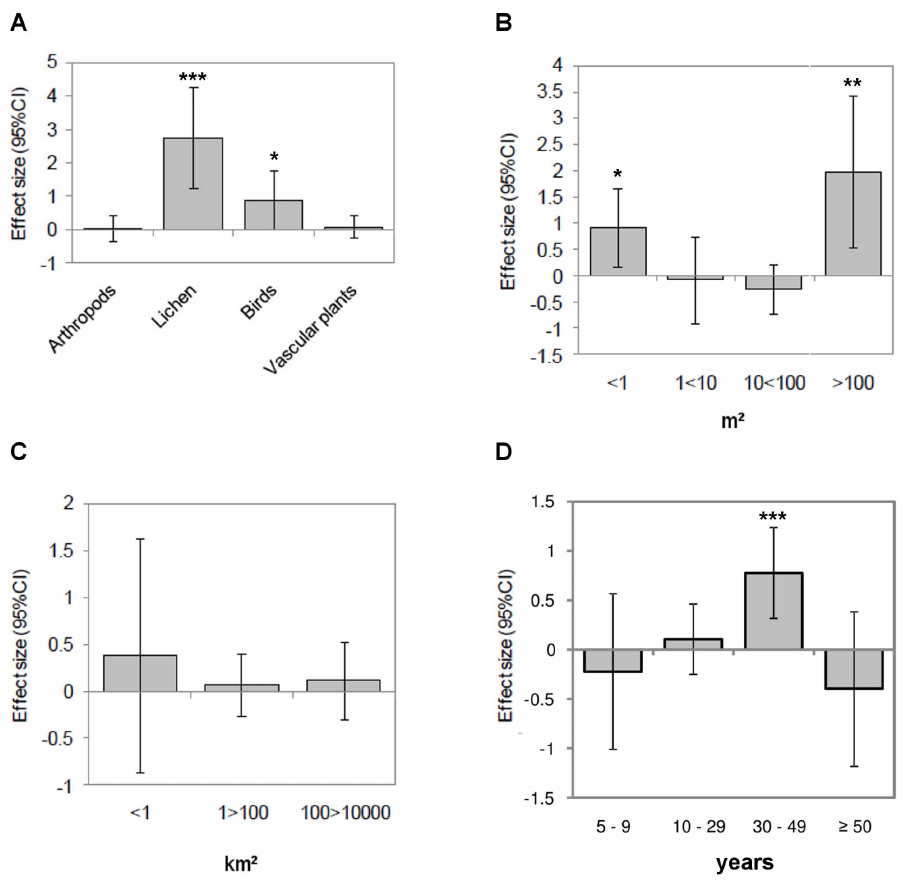
Figure 4. Effect size (95% CI) of land abandonment for (A) taxon; (B) unit size of study; (C) extent of study area; (D) time since abandonment. Q-test shows significant different effect sizes between groups (heterogeneity) for taxon (Q=16.95, P=0.002) and time since abandonment (Q=12.68, P=0.013), but not for extent (Q=0.86, P=0.8356).